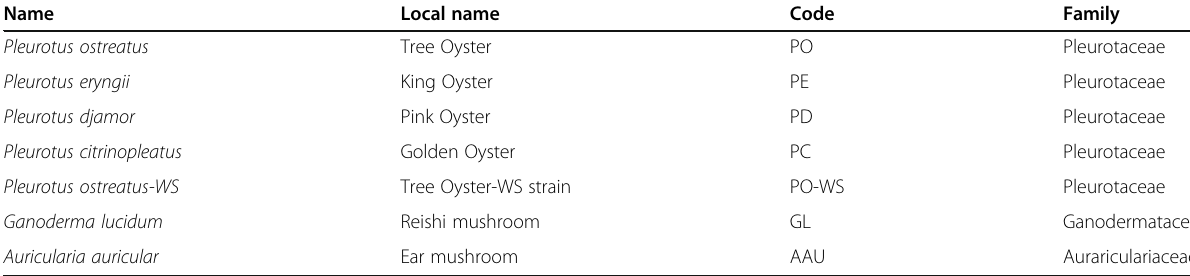
Table 1 Name and families of collected Bangladeshi cultivated